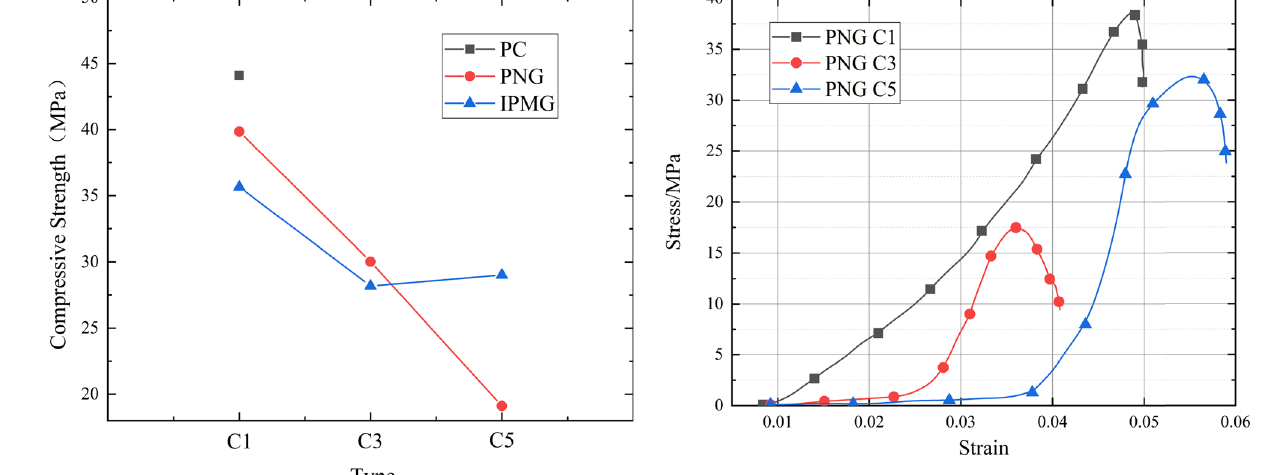
Figure 8: PNG stress – strain curve.